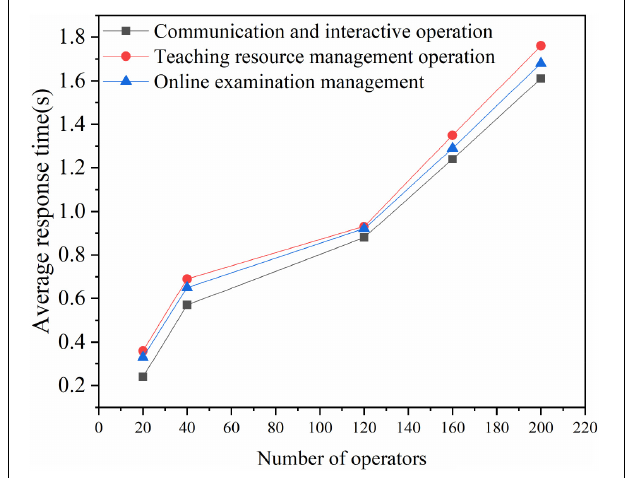
FIGURE 6 | Basic information management of film and television multimedia information management system.